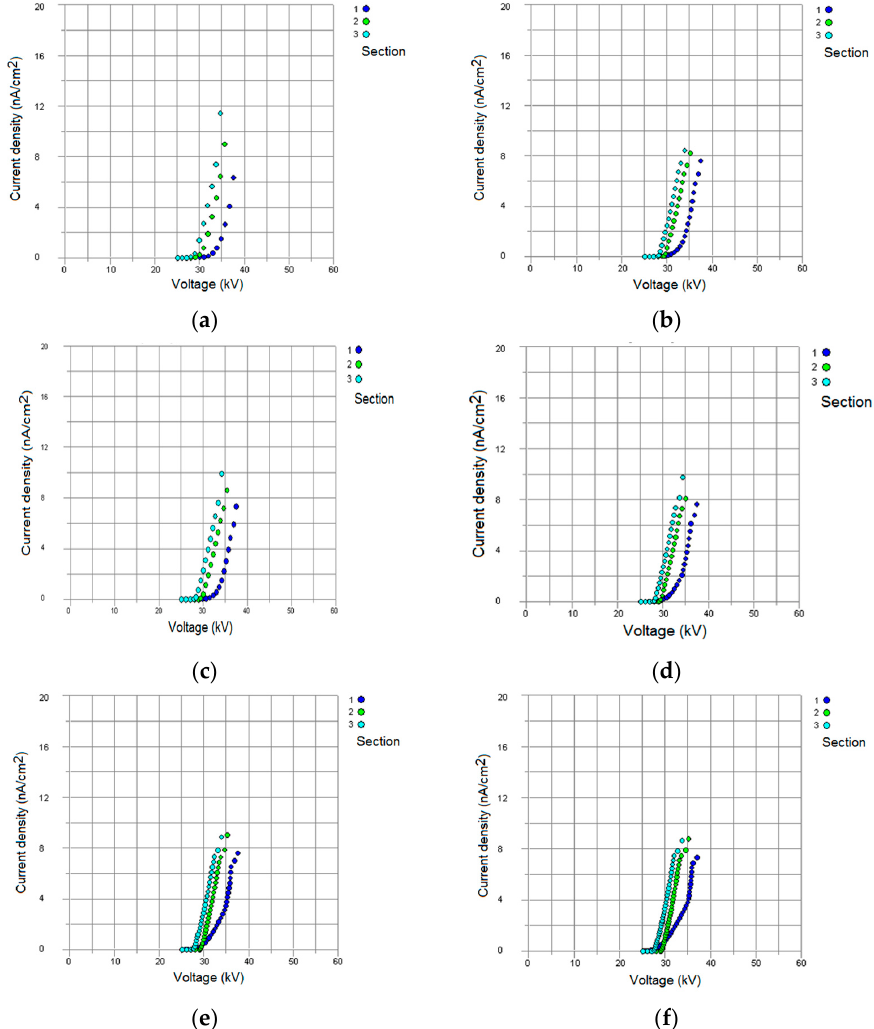
Figure 6. Current density ‐ voltage characteristics at: ( a ) ideal voltage; ( b ) half ‐ wave rectified voltage; ( c ) full ‐ wave rectified voltage; ( d ) the 3rd ‐ order intermittent voltage; ( e ) the 5th ‐ order intermittent voltage; ( f ) the 7th ‐ order intermittent voltage.